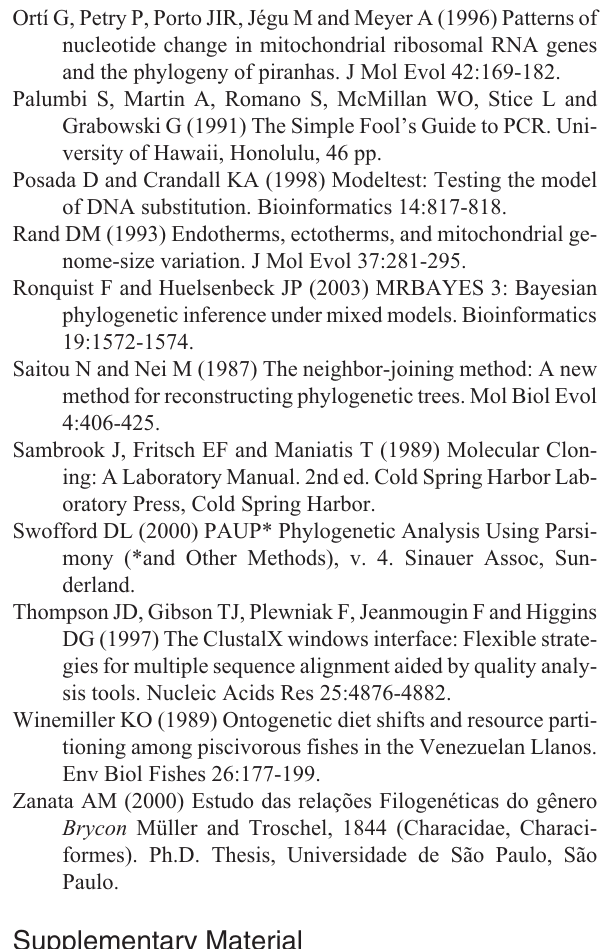
- Table S1: Specimen and sequence